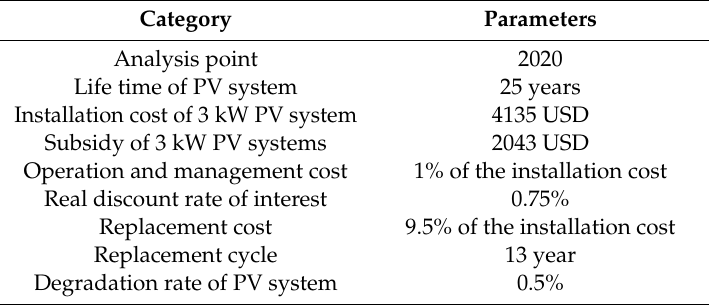
Table 10. Assumptions for economic